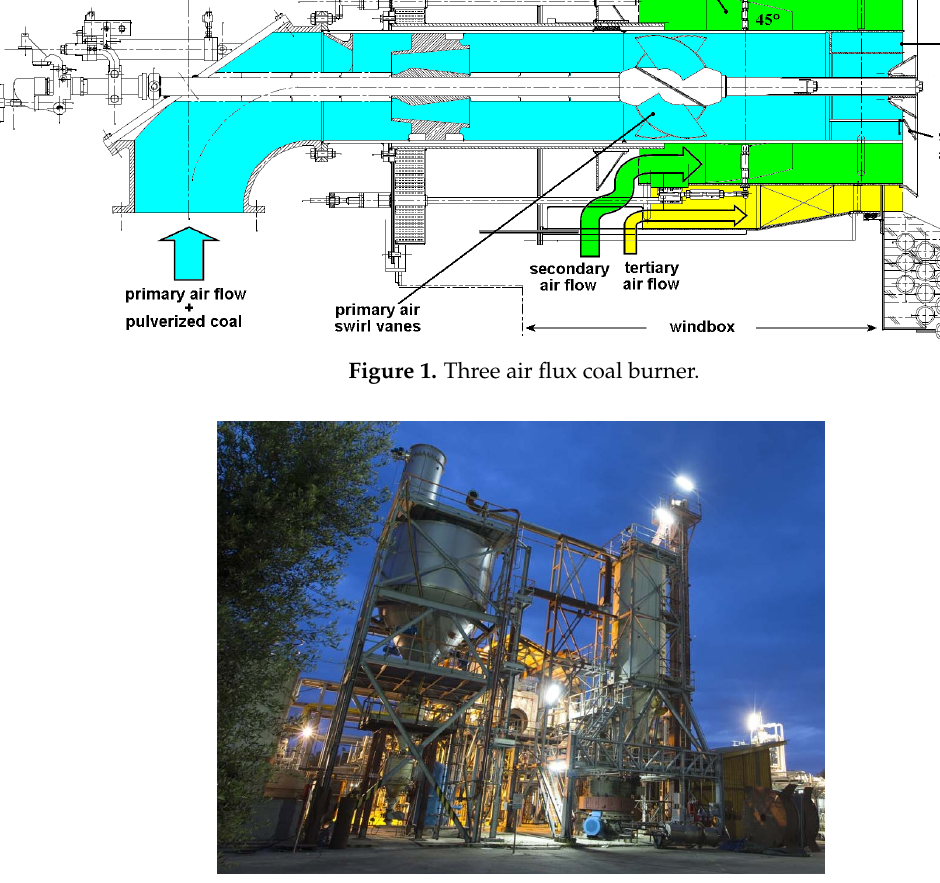
Figure 2. Night view of the 48 MW th experimental facility at CCA, Gioia del Colle,